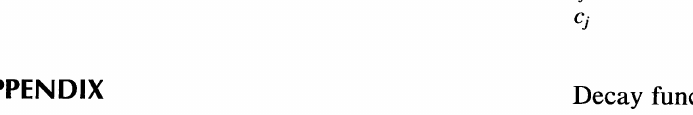
FIGURE 5(c) Phase function Y(W)(X2 -